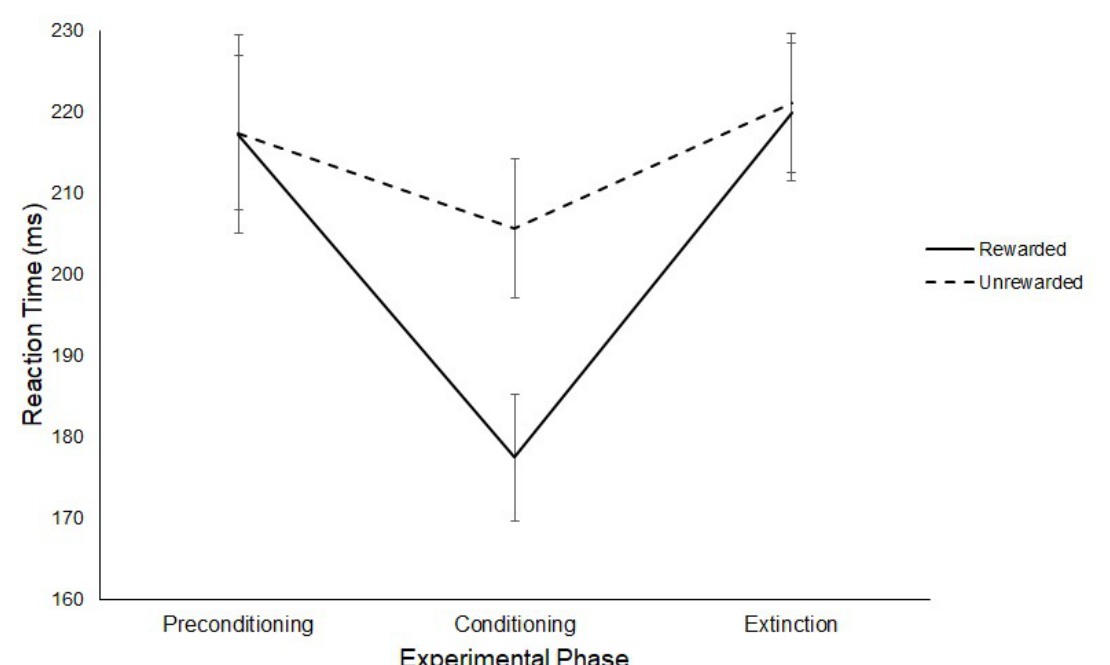
Figure 6. Latency of prosaccades to the rewarded and unrewarded hemifields across the preconditioning, conditioning and extinction phases of the reward paradigm in Experiment 1. Error bars show +/−1 SEM.